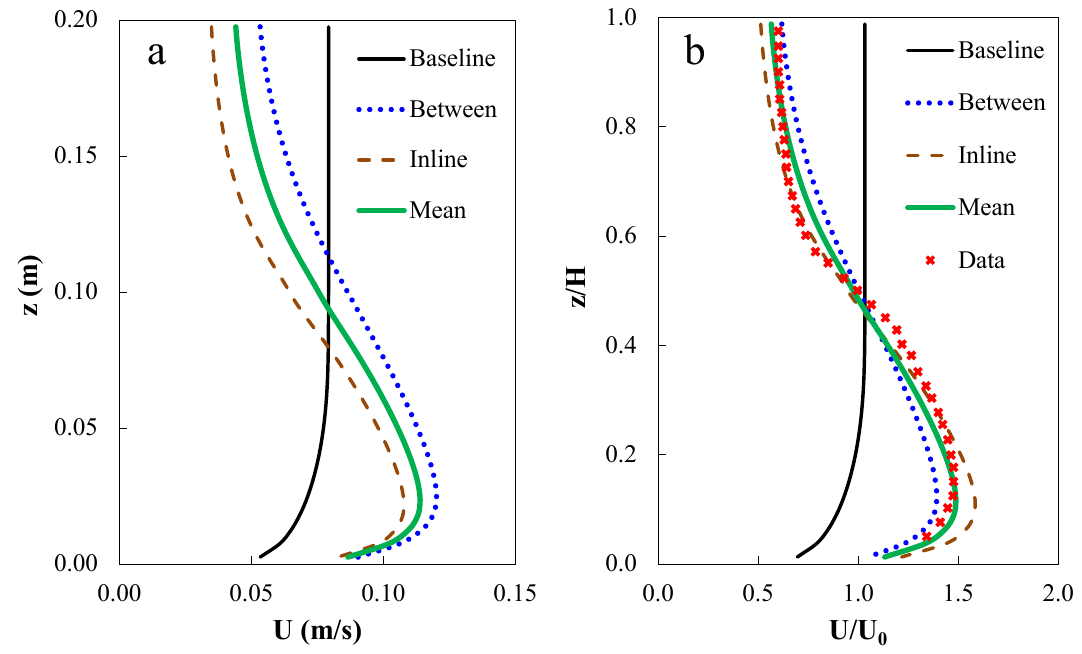
Figure 3. ( a ) FVCOM predicted vertical velocity profiles for Validation Run A. ( b ) Normalized velocity profiles for validation Run A compared to the experimental measurements. a